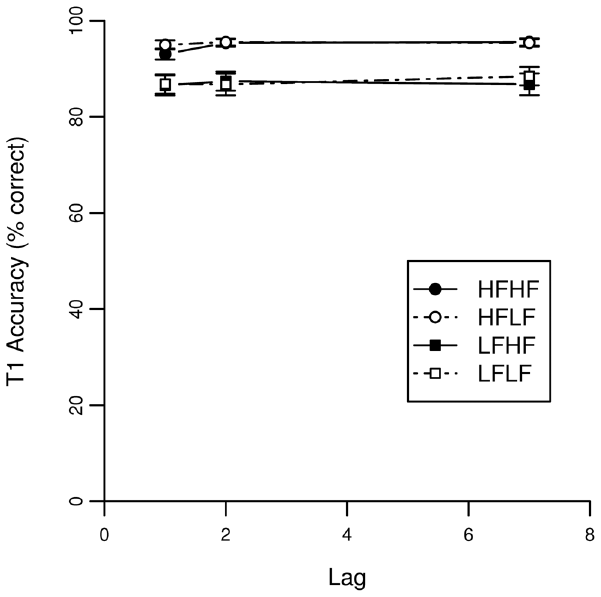
Figure 1. Accuracy scores of the AB task for T1 in Experiment 1. The lag corresponds to the temporal location of T2 relative to T1.